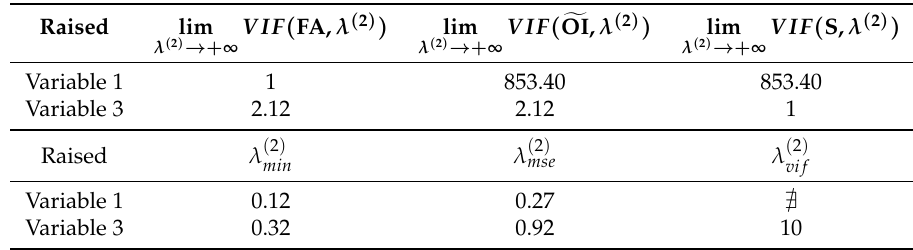
Table 7. Horizontal asymptote for VIFs after raising each variables in the second raising for λ ( 2 ) and λ vif